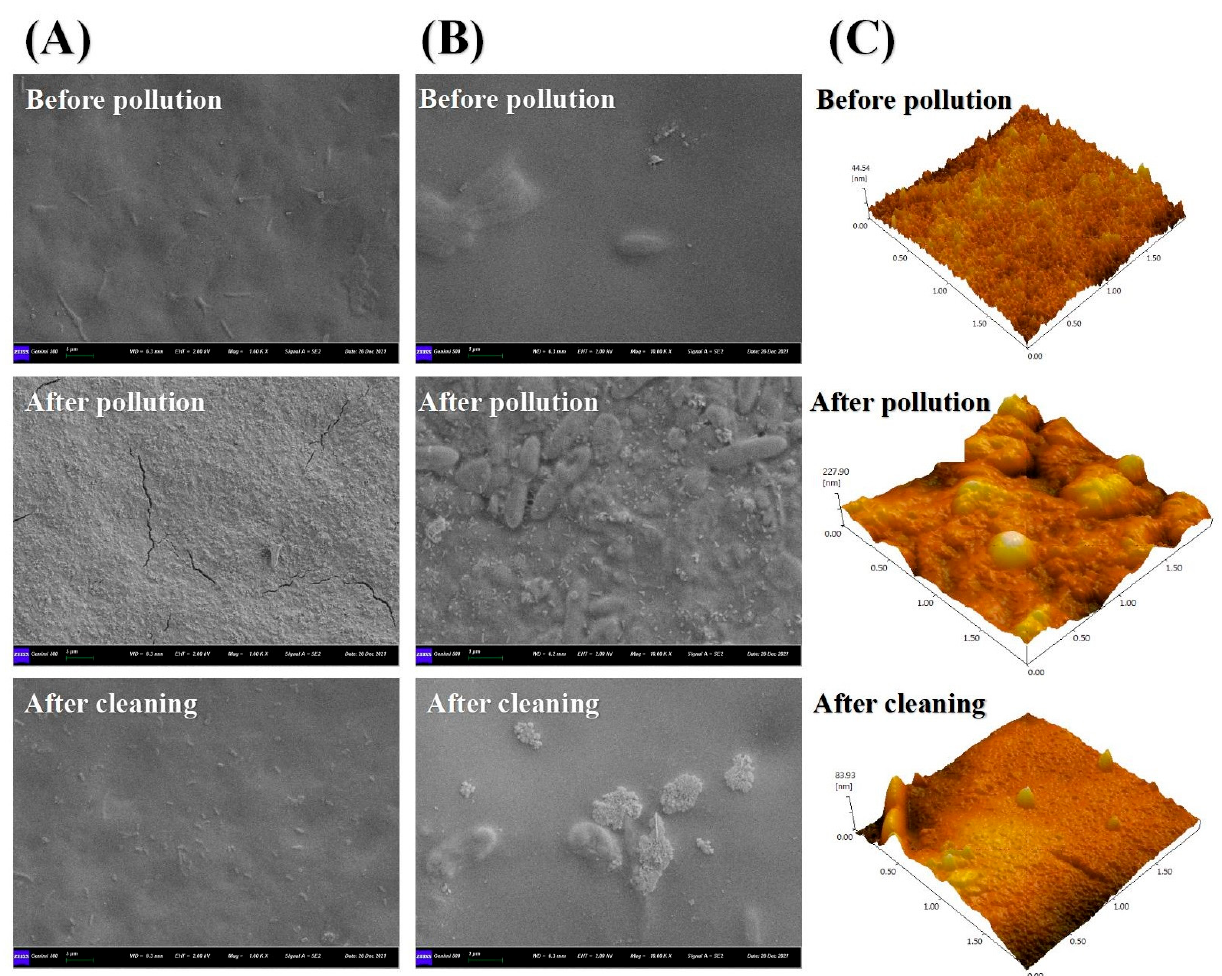
Figure 7. SEM images (5 um scale) ( A ), (1 um scale) ( B ), and AFM images ( C ) of FO membrane before pollution, after pollution and after cleaning.